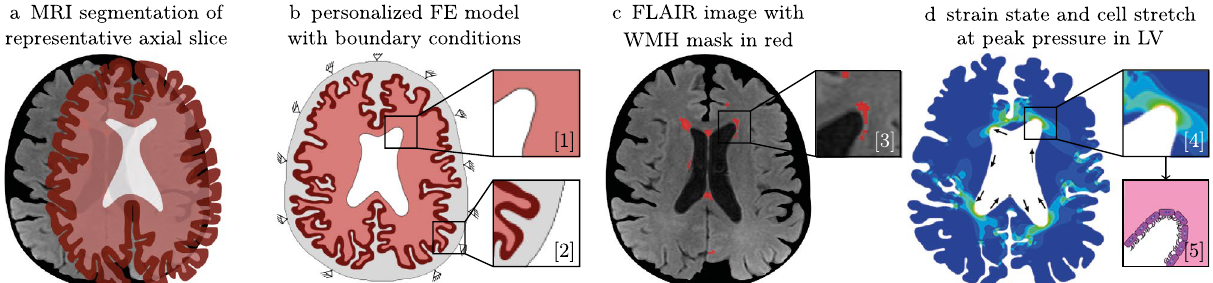
Figure 3. We generated finite element models for each subject individually by segmenting axial MRI through the lateral ventricle. ( a ) We identified the boundaries of gray matter, white matter, lateral ventricles, and cerebral spinal fluid surrounding the cortex. ( b ) The model was kinematically constrained along the outer boundary, and we applied a pressure normal to the ventricular wall (b1) and normal to the outer gray matter surface (b2). ( c ) Accompanying FLAIR images superposed with a mask of white matter hyperintensities show the localization of early leukoaraiosis in the ventricular horns (c3). We simulated peak loading during the hemodynamic pressure cycle in order to obtain the strain field (d4) and ependymal cell stretch along the ventricular wall